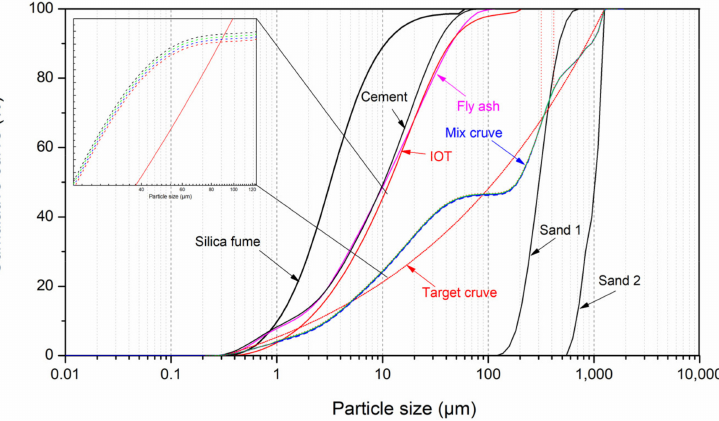
Figure 3. Particle size distributions of the ingredients, target, and optimized grading curves of different ultra-high performance concrete (UHPC) mixtures.